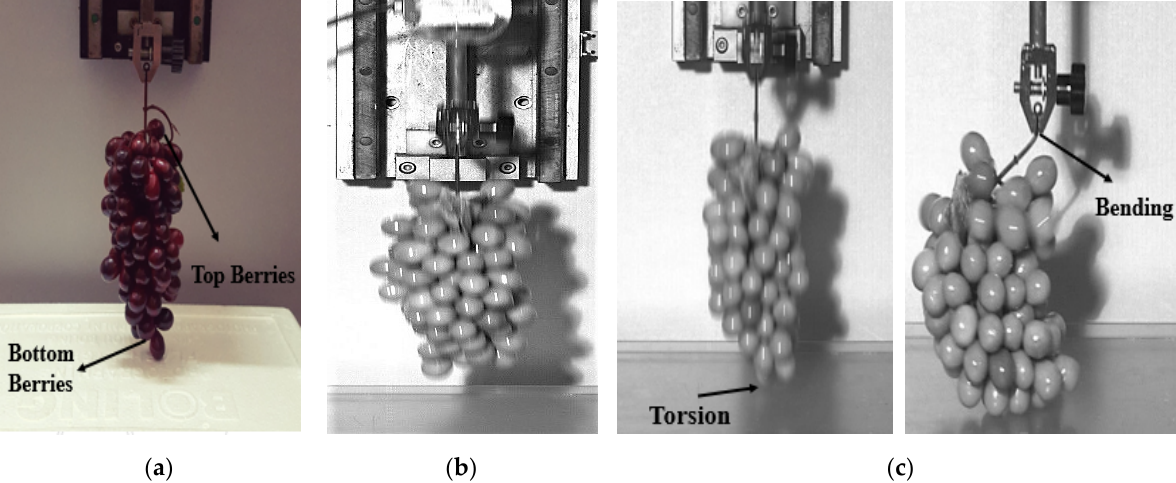
Figure 6. Load on the berries of the grape cluster during the placing phase: ( a ) grape cluster; ( b ) transportation load; ( c ) placing load.